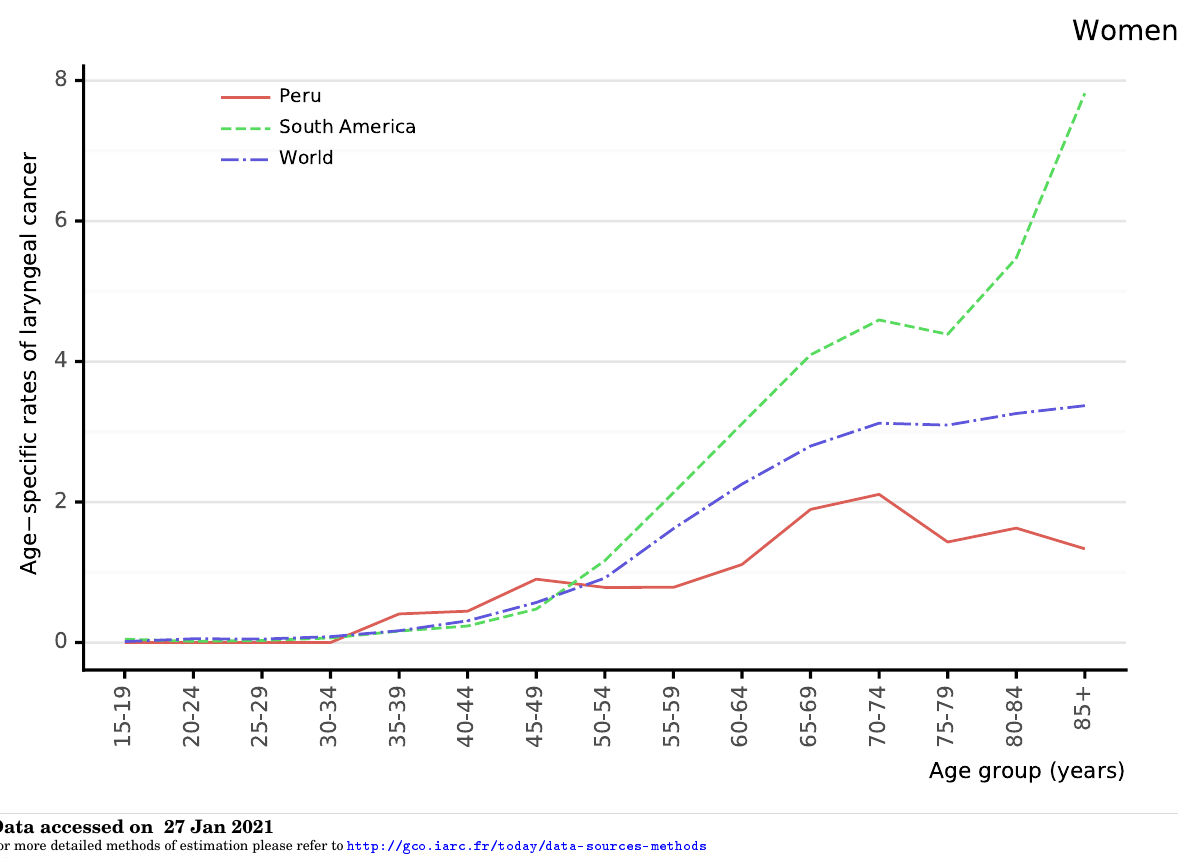
Figure 104: Comparison of age-specific laryngeal cancer incidence rates among women by age in Peru, within the region, and the rest of